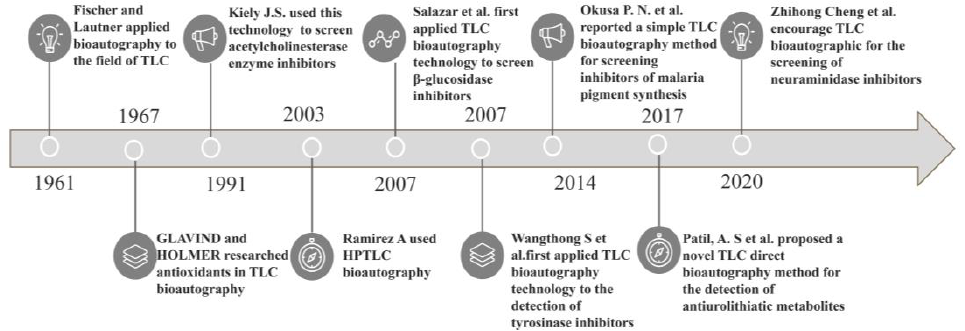
Figure 1. Historical development of TLC bioautography. This figure summarizes the significant experiments in the period starting from the invention of the technique in 1961 to the screening of neuraminidase in